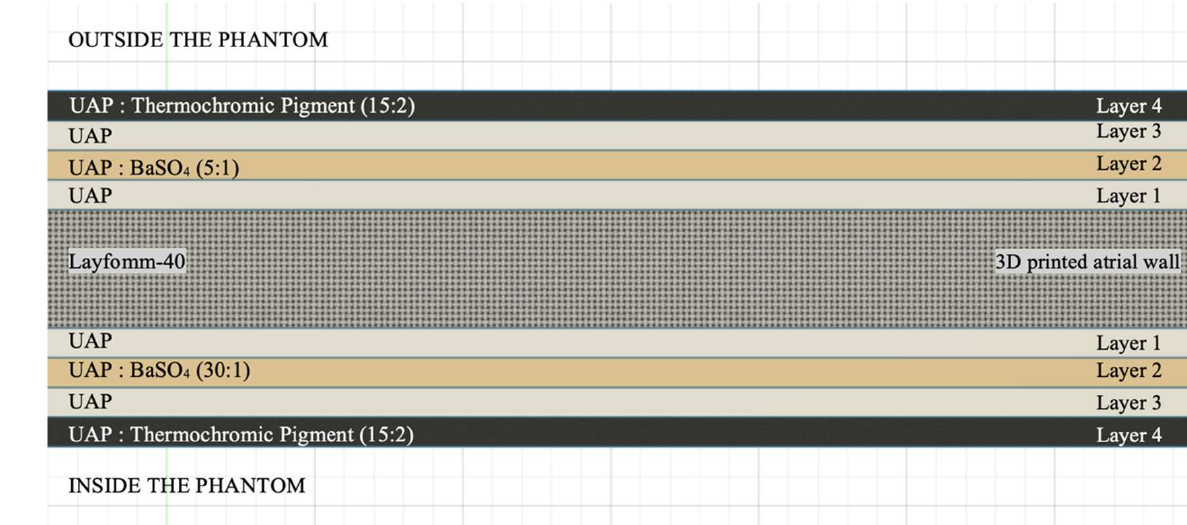
Figure 5. Architecture of custom paint coatings of the Layfomm-40 model.